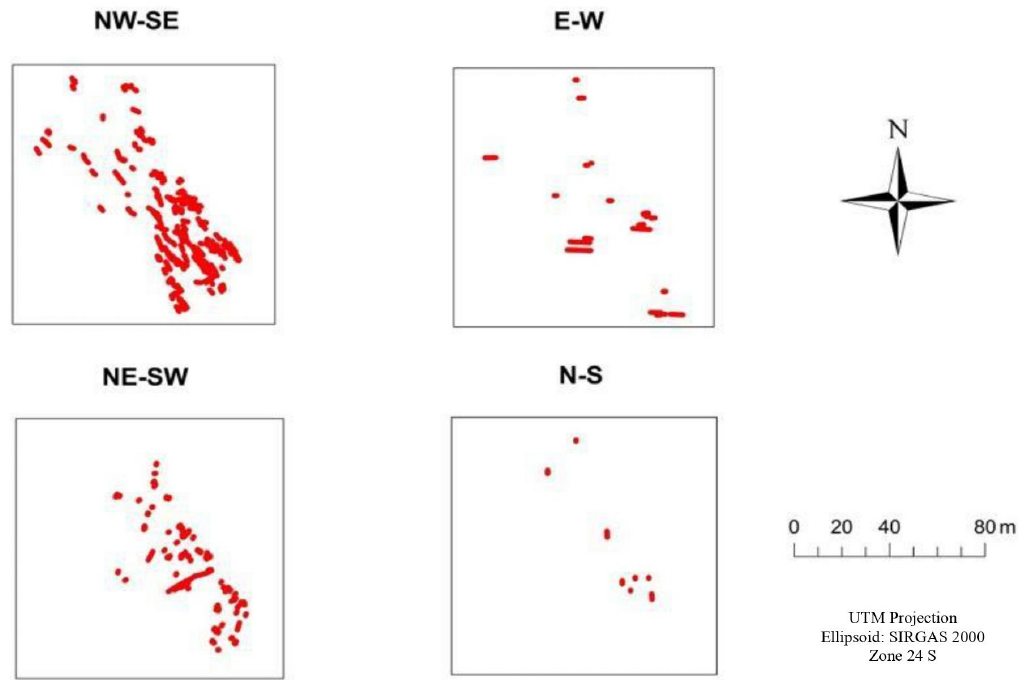
Figure 10. Directional maps of linear features manually extracted on the